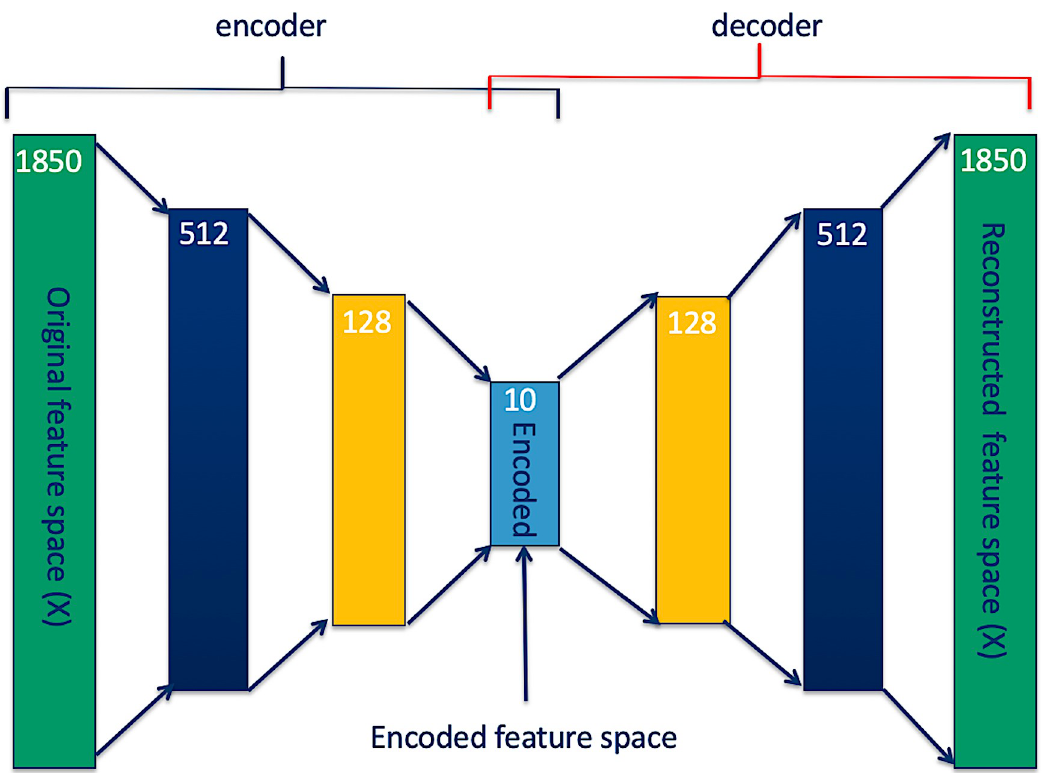
Fig 2. Autoencoder reducing feature space